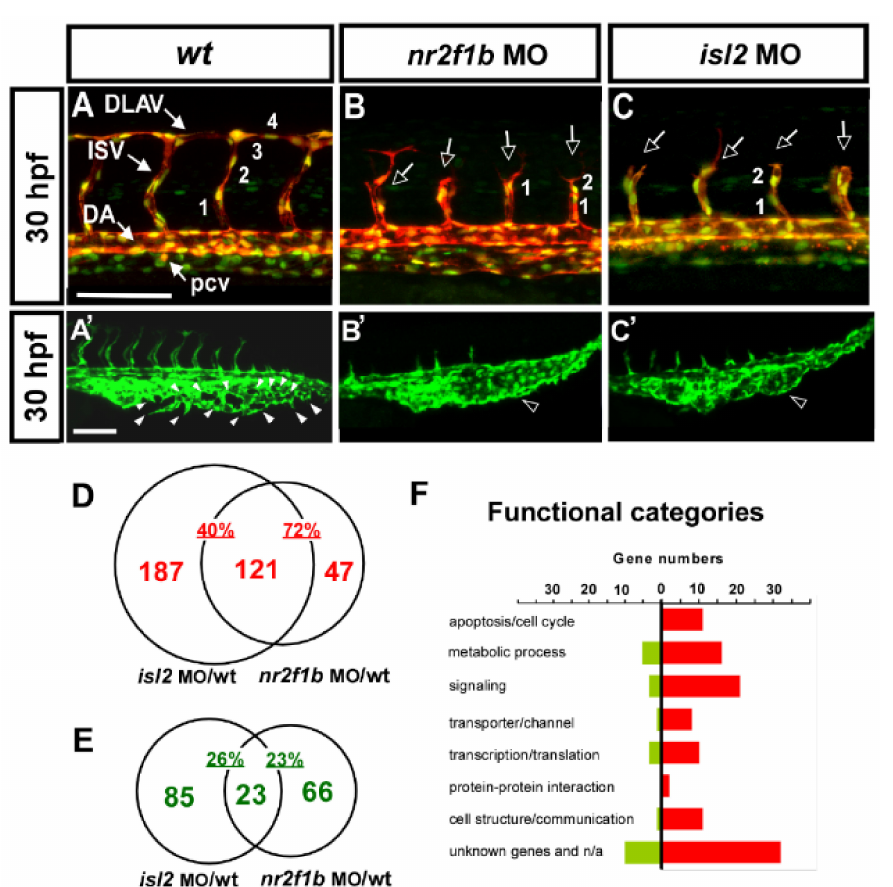
Figure 1. Loss of nr2f1b and isl2 causes vascular defects, and transcriptome analysis identified genes regulated by Nr2f1b and/or Isl2. ( A – C , A (cid:48) – C (cid:48) ) knockdown of isl2 or nr2f1b causes ISV growth stalling in the middle line of the somite, a reduction of the ISV endothelial cells, ( B , C ) and a mis- patterned vessel plexus at the CVP ( B (cid:48) , C (cid:48) ) at 30–32 hpf when compared to wt controls ( A , A (cid:48) ). ( D , E ) Microarray data analysis in Venn diagrams show that there were 308 and 168 genes upregulated at isl2 MO and nr2f1b MO, respectively, compared to wt, as well as 121 overlapping genes in both isl2 MO and nr2f1b MO when compared to the wild type ( D ). ( E ) For the repression targets, 108 and 89 genes are downregulated at isl2 MO and nr2f1b MO, respectively, compared to wt, and 23 genes are overlapped. ( F ) Functional analysis showed many genes involved in cell cycle regulation, signaling, transporter/channels, transcription, cell communication and protein–protein interactions. (ISV, intersegmental vessel; DLAV, dorsal longitudinal anastomotic vessel; DA, dorsal aorta; PCV, posterior cardinal vein; CVP, caudal vein plexus). Scale bars represent 100 µ